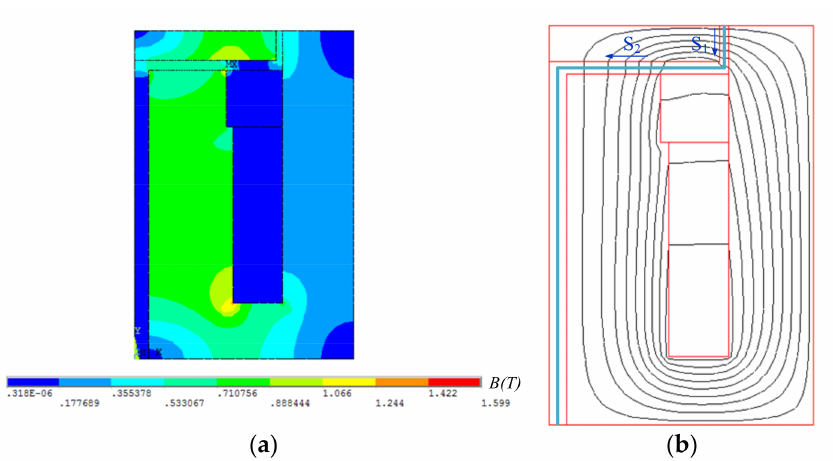
Figure 5. Simulation results of the proposed MR valve: ( a ) magnetic flux density contour, ( b ) magnetic flux line distribution.